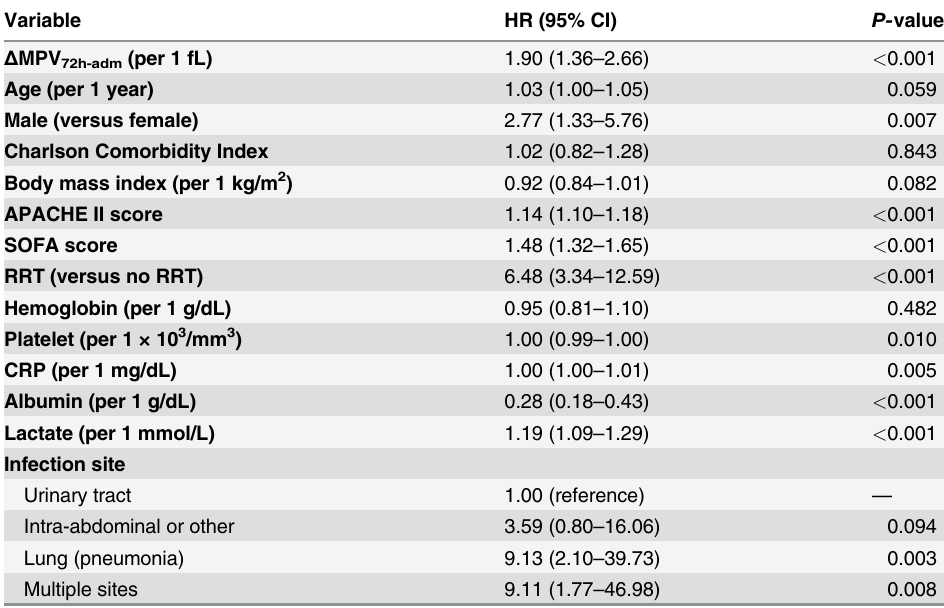
Table 4. Univariate Cox proportional hazards analysis for 28-day all-cause mortality. Variable HR (95% CI) P- value Δ MPV 72h-adm (per 1 fL)